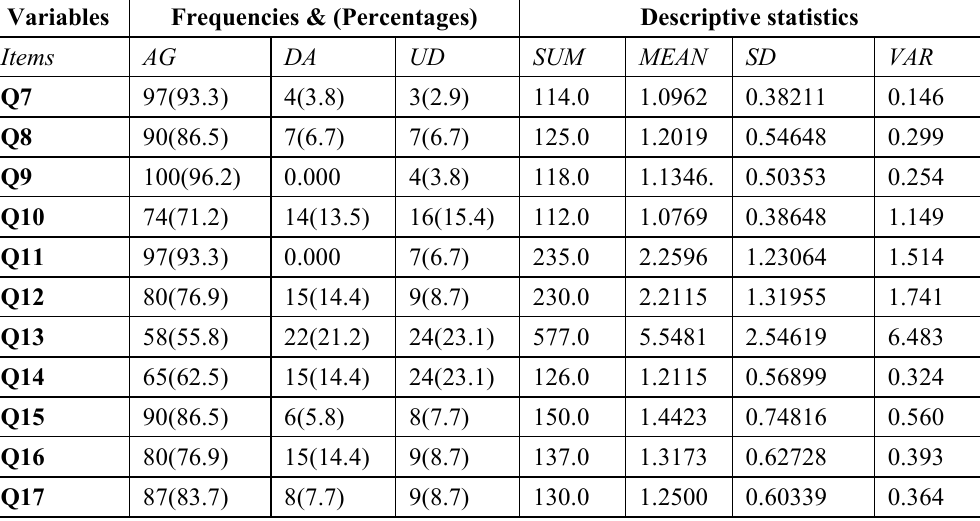
Table 4. Analysis of Data on Dependent Variables (Y) (made by the author) Variables Frequencies & (Percentages) Descriptive